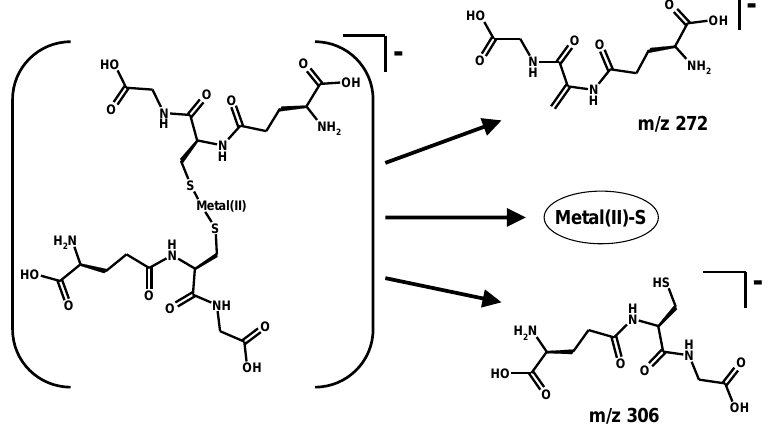
Scheme 6. Decomposition of deprotonated metal(II) glutathione conjugates as observed by mass